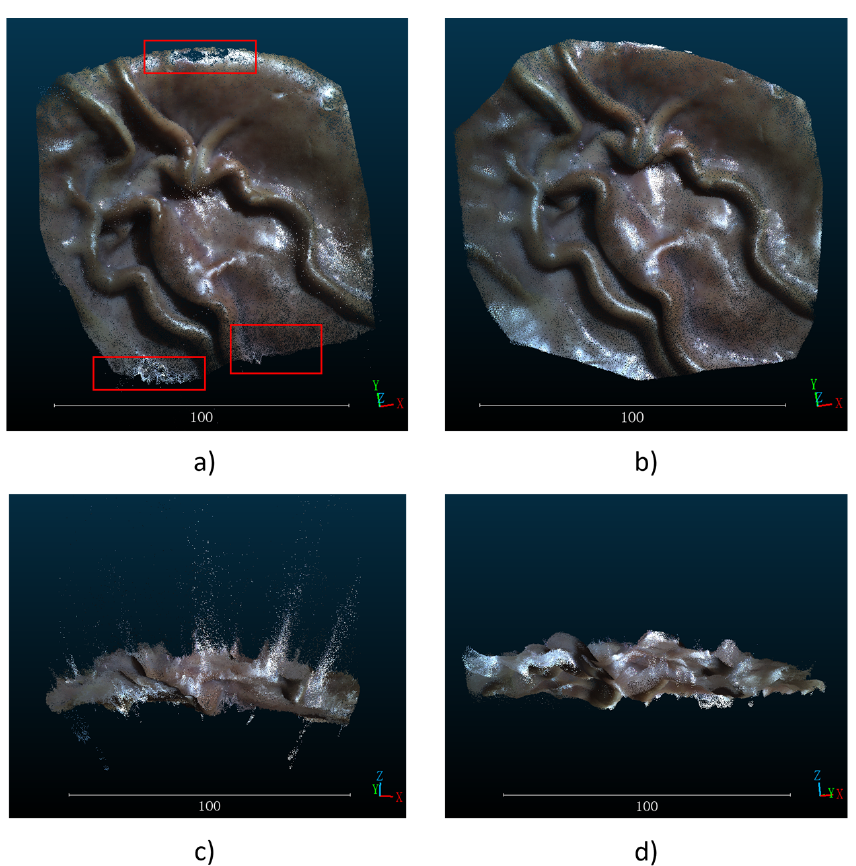
Figure 5. Different views of the depth prediction method. ( a ) Top view of mosaicked point cloud map by SGBM. ( b ) Top view of mosaicked point cloud map by StereoNet. ( c ) Side view of mosaicked point cloud map by SGBM. ( d ) Side view of mosaicked point cloud map by StereoNet.